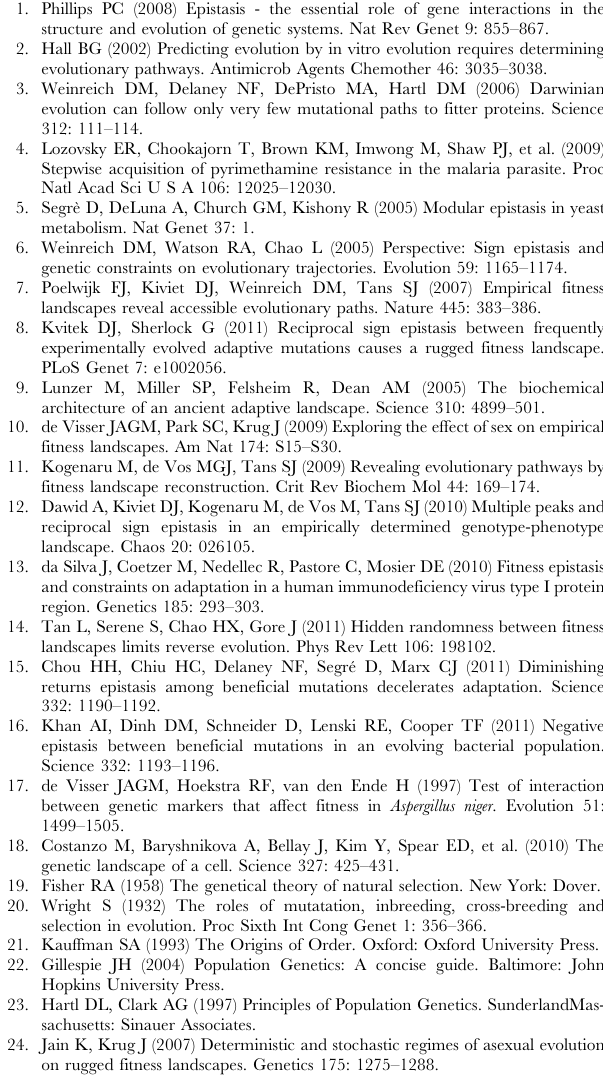
effect becomes more pronounced as L grows. Figure S7 Distribution of the number of accessible paths for the LK model with L ~ 5 and different values of K . For all K § 1 , the most likely outcome is n ~ 0 . Note the pronounced peaks for K ~ 1 , which reflect complex combinatorial correlations among the paths. Figure S8 Mean number of accessible paths obtained from subgraph analysis of the TEM b -lactamase resistance landscape of Weinreich et al. [3] (squares) compared to the results of a subgraph analysis of LK landscapes with L ~ 5 , K ~ 1 (triangles), K ~ 2 (crosses) and K ~ 3 (circles).